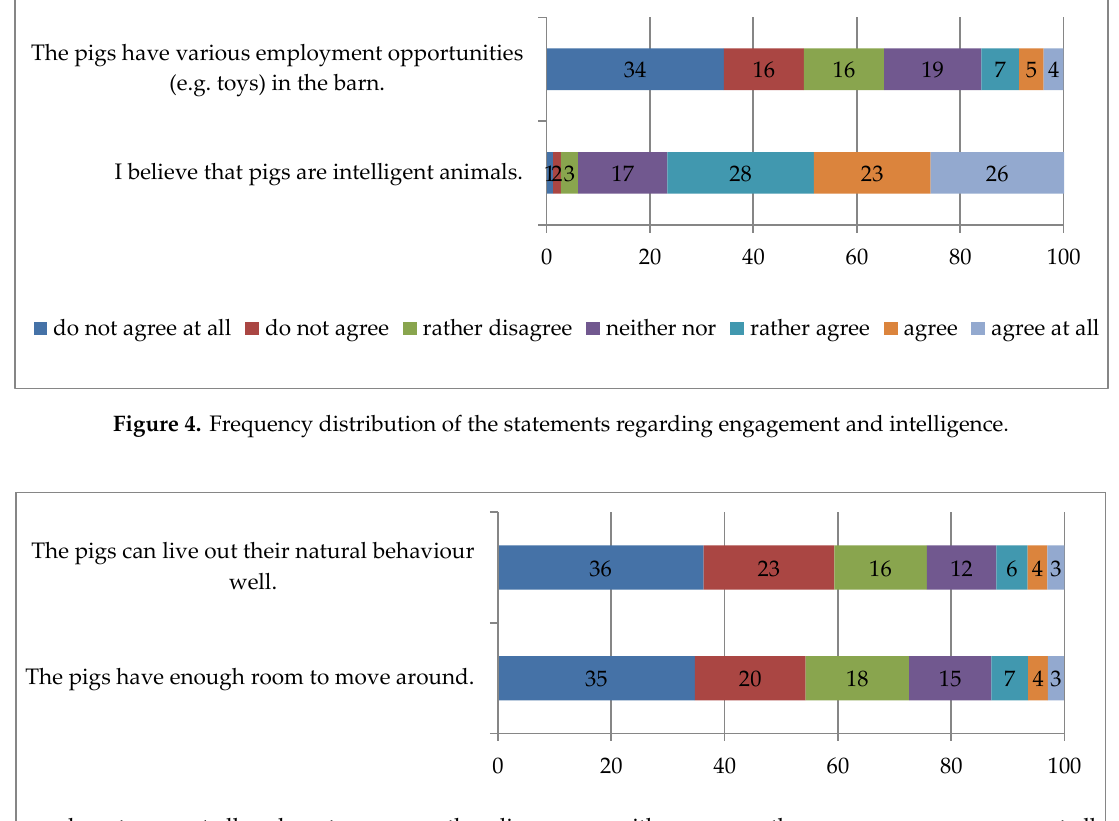
Figure 5. Frequency distribution of the statements regarding available space and natural behavior.